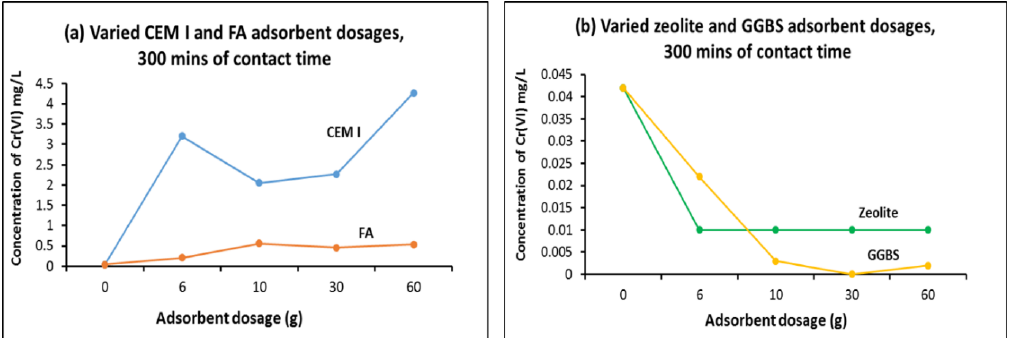
Figure 1. Effect of dosage on adsorption of Cr(VI) by various adsorbents after 300 mins of contact time with the AMD : ( a ) CEM I and FA adsorbents; ( b ) Zeolite and GGBS adsorbents.